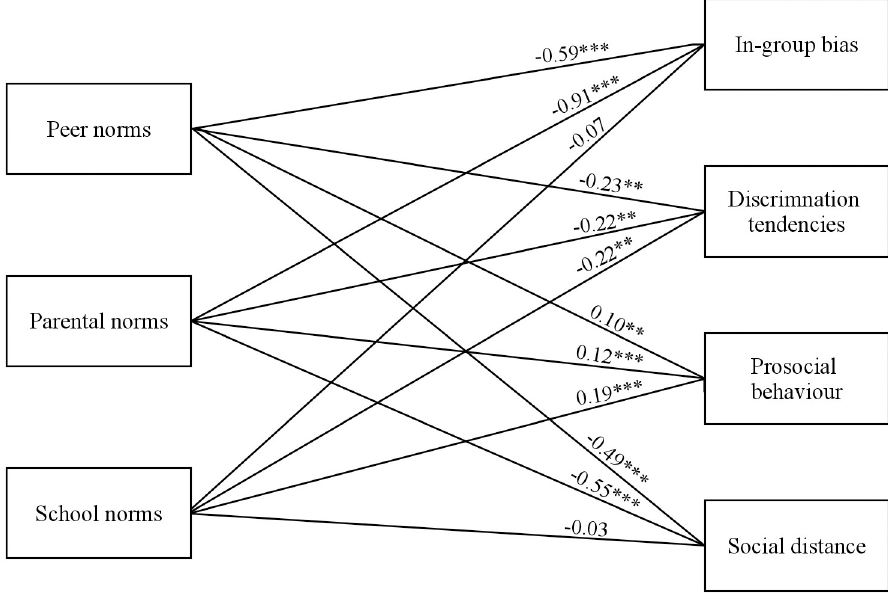
Fig 1. Path model of normative effects on intergroup outcomes for the total sample. Predictor path estimates are unstandardised regression coefficients (b). �� p < 0.01, ��� p < 0.001.